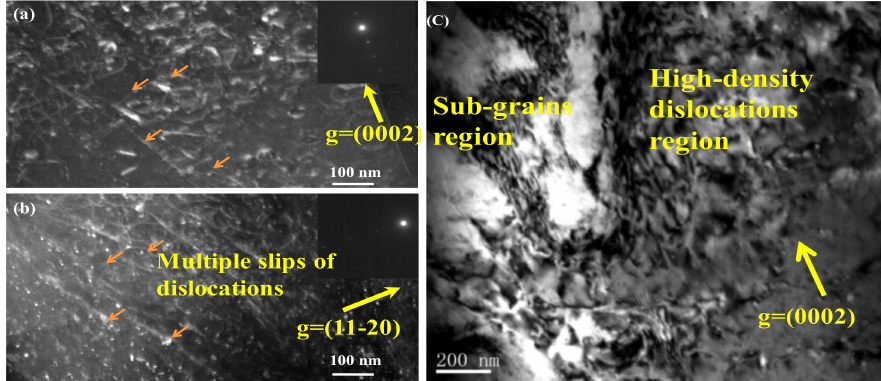
Figure 5. TEM weak-beam images taken from specimens deformed up to a strain of 0.20; ( a , b ) show the activated dislocations type, and ( c ) shows the microstructural